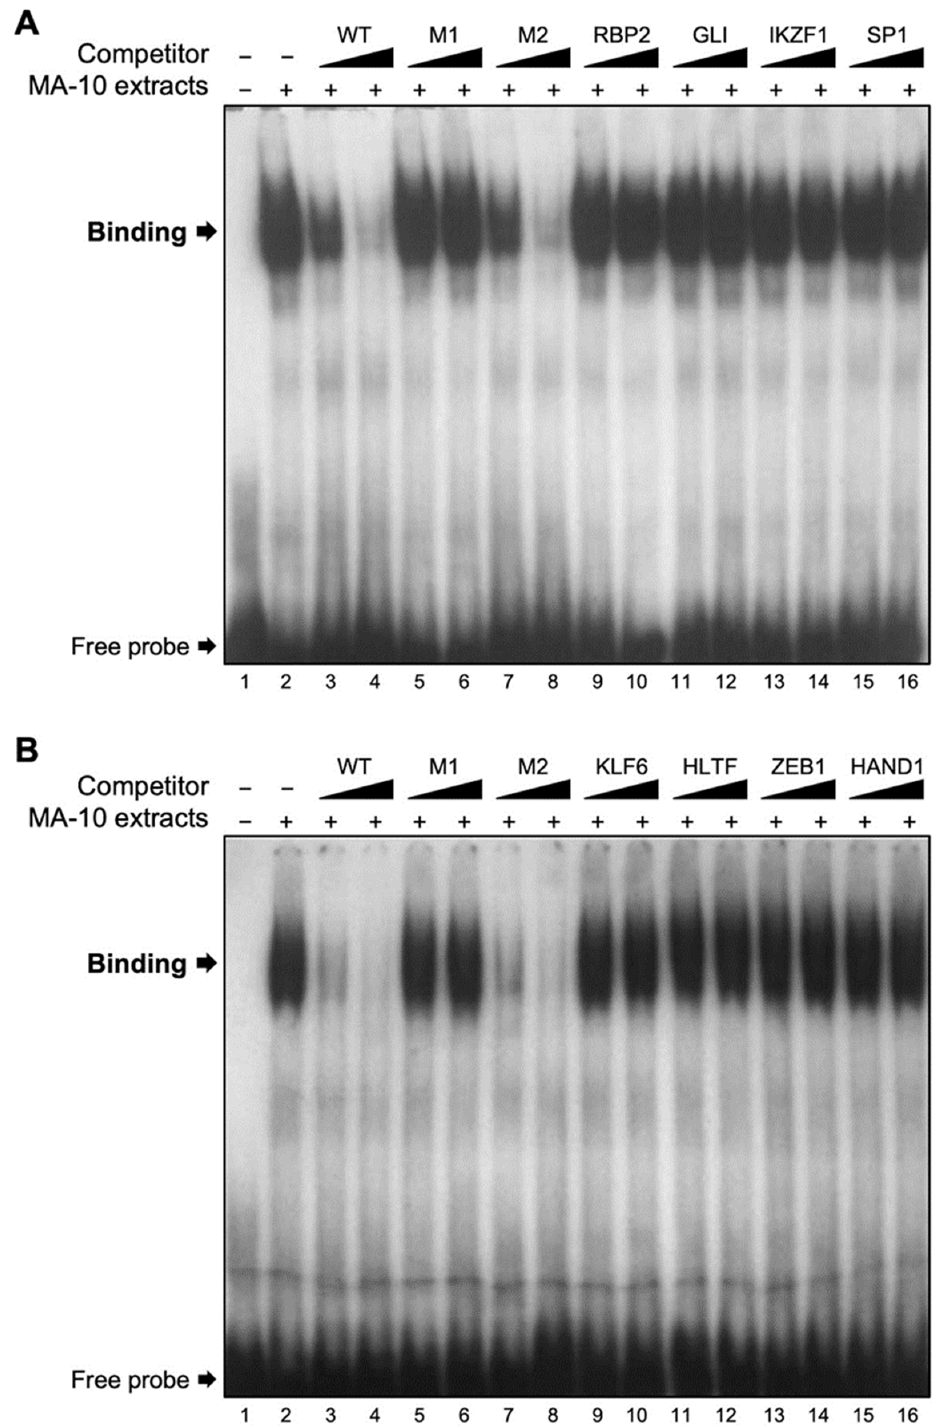
Figure 5. Assessment of potential transcription factors binding to the 35-bp region. EMSA was used to challenge the binding of nuclear protein(s) from MA-10 Leydig cells (MA-10 extracts) to a double-stranded 32 P-labelled oligonucleotide corresponding to the 35-bp region ( − 186 to − 151 bp) of the Insl3 promoter. Protein binding was challenged by increasing concentrations (black triangles; molar excesses of 5 × and 25 × ) of unlabelled oligonucleotides corresponding to the wild-type 35-bp region (WT), mutants M1 and M2, or oligonucleotides containing a consensus binding sequence for transcription factors ( A ) RBP2, GLI, IKZF1, SP1, and ( B ) KLF6, HLTF, ZEB1, HAND1.